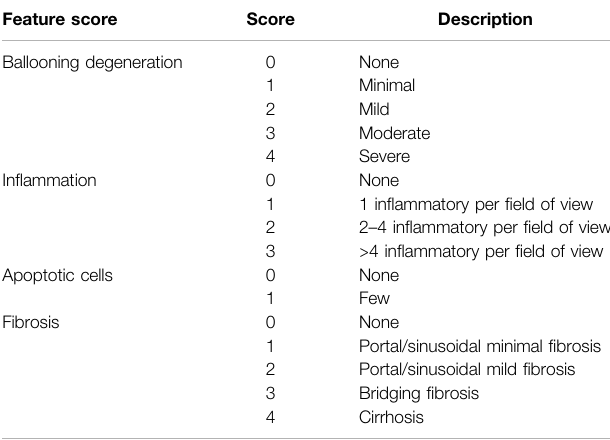
TABLE 1 | Liver pathology